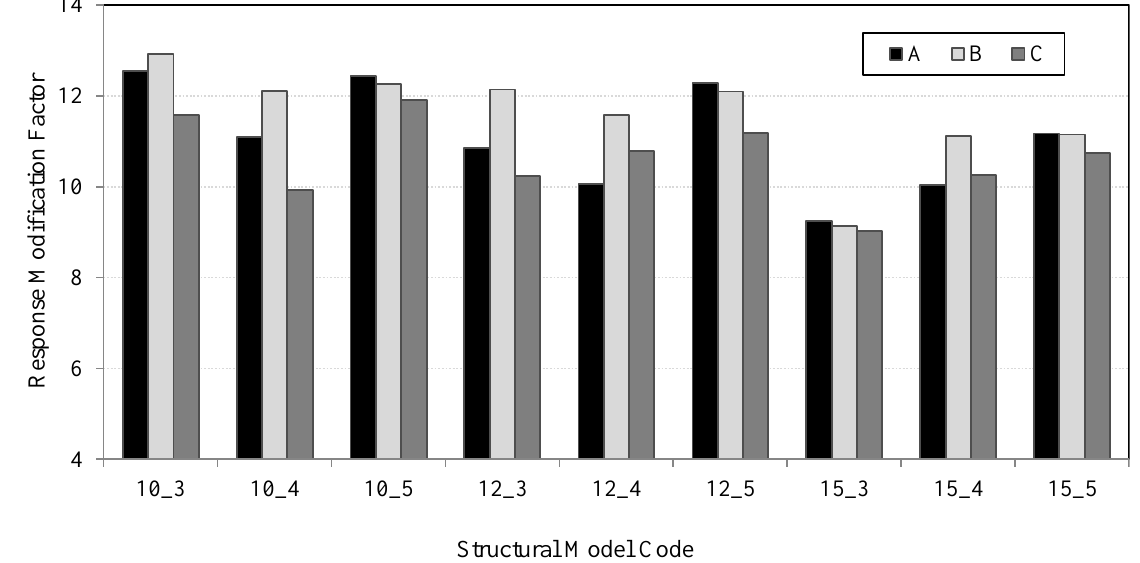
Fig. 10. Response modification factors of different